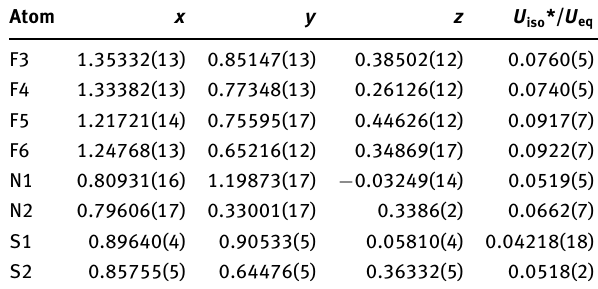
Table 2: Fractional atomic coordinates and isotropic or equivalent isotropic displacement parameters (Å 2